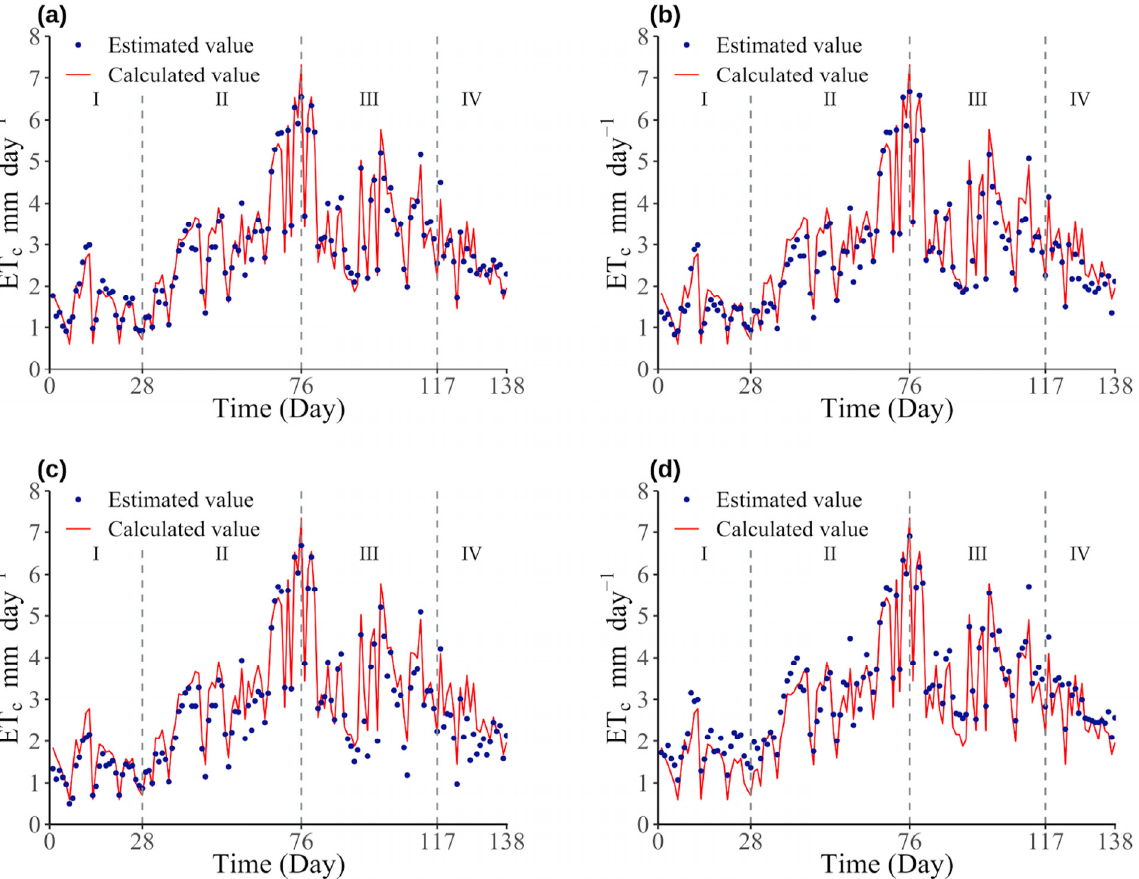
Figure 6. Comparison of simulated and calculated values of spring maize ET c in 2019 of different models with K c , T ave , n and RH as the input: RF–SVR–PSO model ( a ), SVR model ( b ), BPNN model ( c ) and RF model ( d ). The areas labeled I, II, III and IV indicate the initial stage, crop development stage, mid-season stage and late-season stage, respectively .